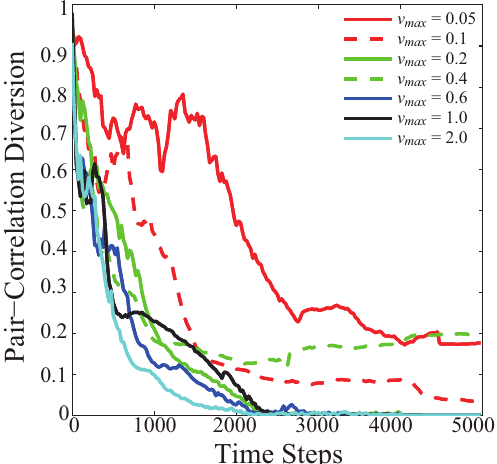
Figure 2. Pair correlation diversion as a time-step function for the indicated maximum node velocity v max = 0.05, 0.1, 0.2, 0.4, 0.6, 1.0, and 2.0,